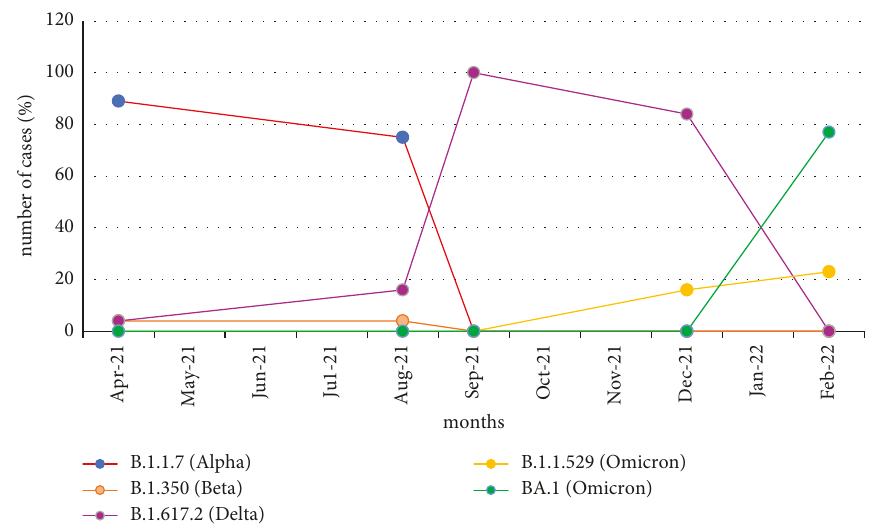
Figure 3: SARS-CoV-2 variant peaks and waves by